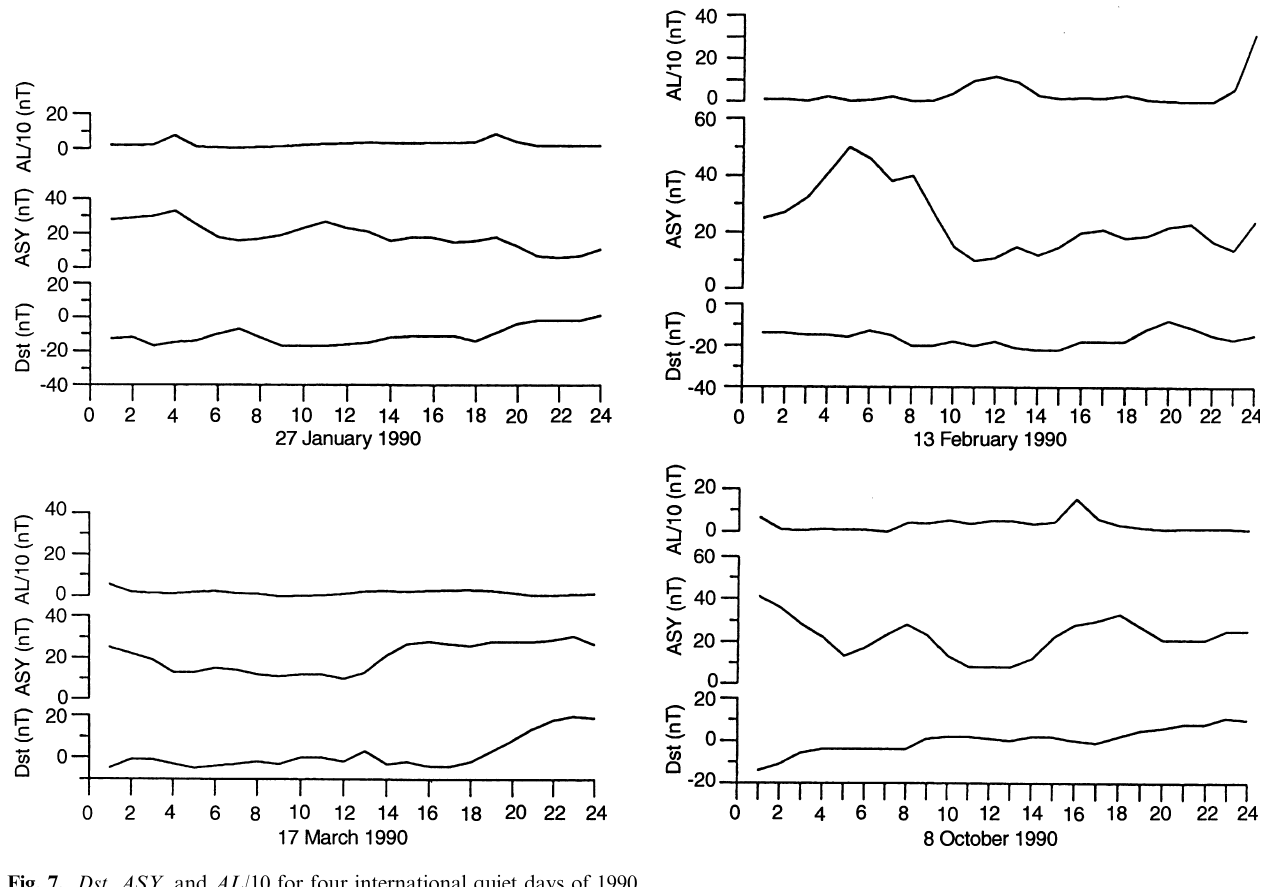
Table 2. To estimate the DS 1 variation the observation points were balanced using the method of least squares